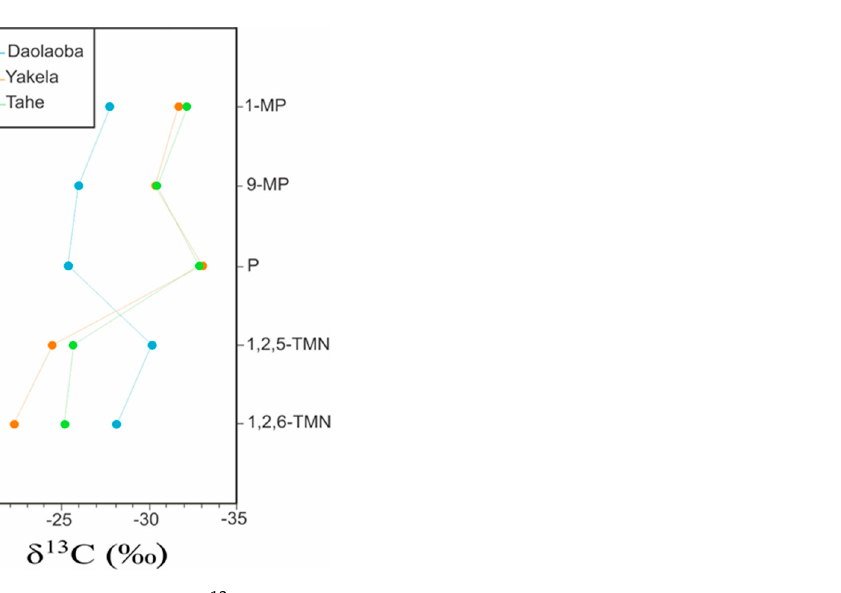
Figure 5. Repartition of δ 13 C of 1,2,6-TMN (trimethylnaphthalene), 1,2,5-TMN (trimethylnaphtha- lene), P (Phenanthrene), 9-MP (methylphenanthrene), and 1-MP (methylphenanthrene) in 20 selected oils of Tarim basin.